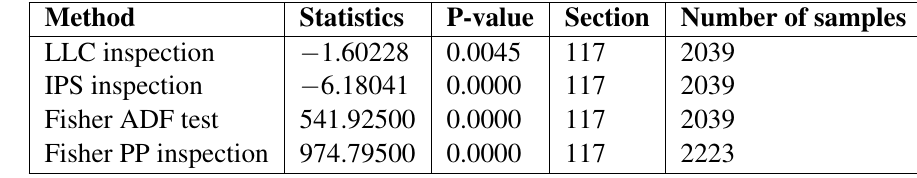
Table 1 Unit root test results of 14 listed agricultural companies’ stock prices and eight financial indicators from 2013 to